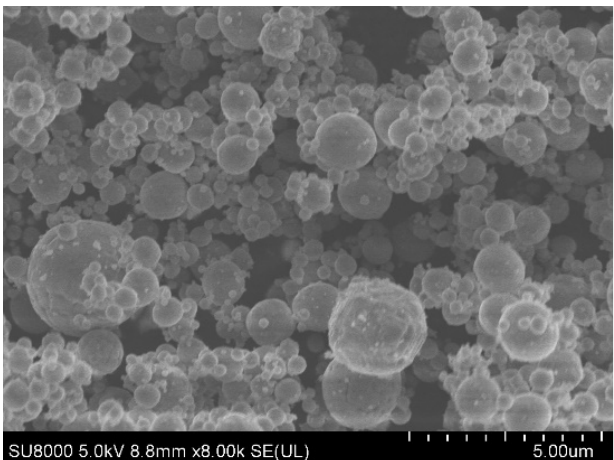
Figure 3. Particle size distribution of manganese ore powder.